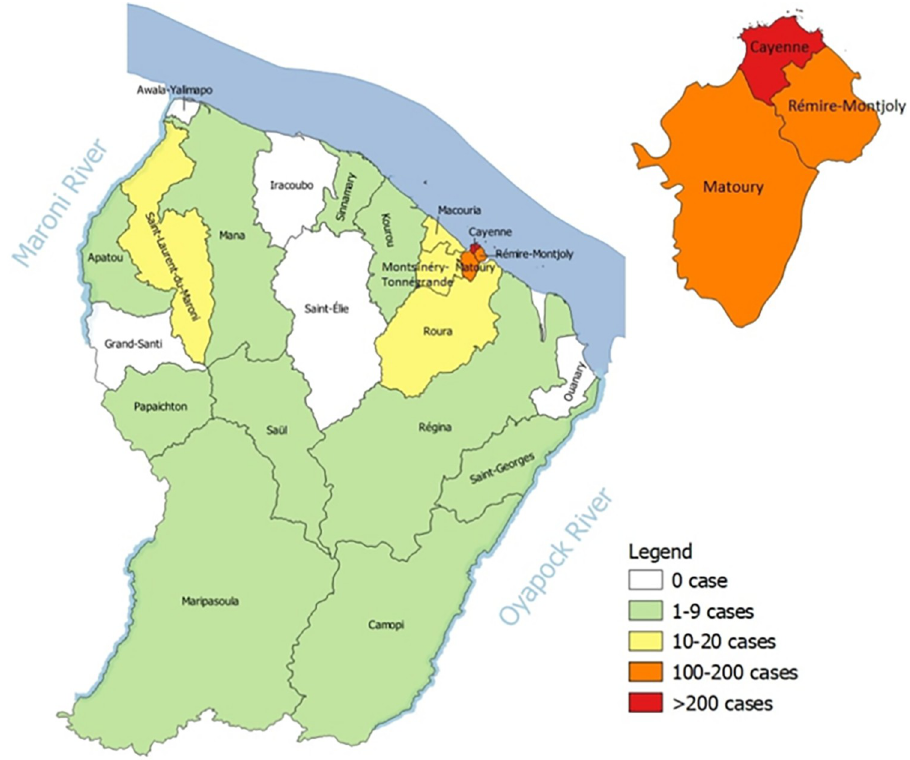
Fig 4. Mapping of the cases of Q fever per municipality in French Guiana 2007–2017. Source: QGIS software, release 3.24. Link to the base layer: https://www.insee.fr/fr/information/2028028.